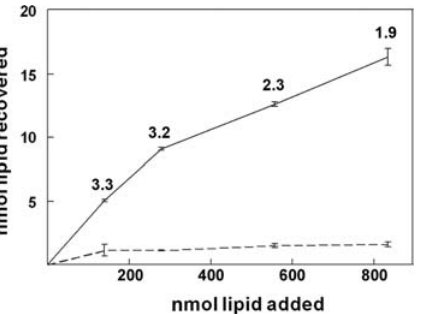
Figure 1. The p14 FAST protein lacks specific receptor-binding activity. Fluorescent liposomes were prepared with (solid line) or without (dashed line) p14, and increasing doses of the liposomes (nmol of lipid) were added to monolayers of QM5 fibroblasts at 4 u C. The total nmol of lipid bound were determined by fluorimetry in reference to a standard curve of phospholipid concentrations. Data is presented as the mean 6 S.D. of a single experiment conducted in triplicate. Numbers within the graph indicate the percent binding efficiency at each input dose of liposomes.